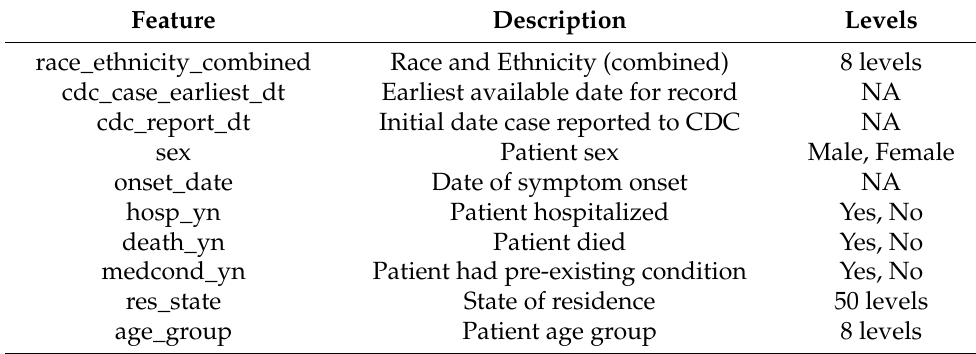
Table 1. Features selected for analysis and their